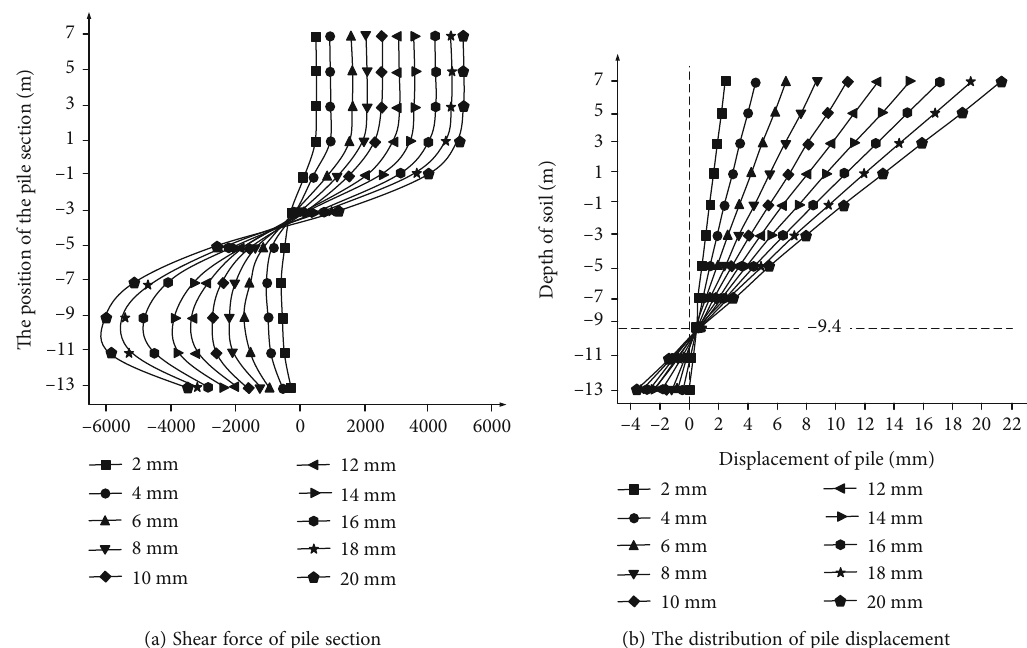
Figure 8: The shear and displacement distribution of